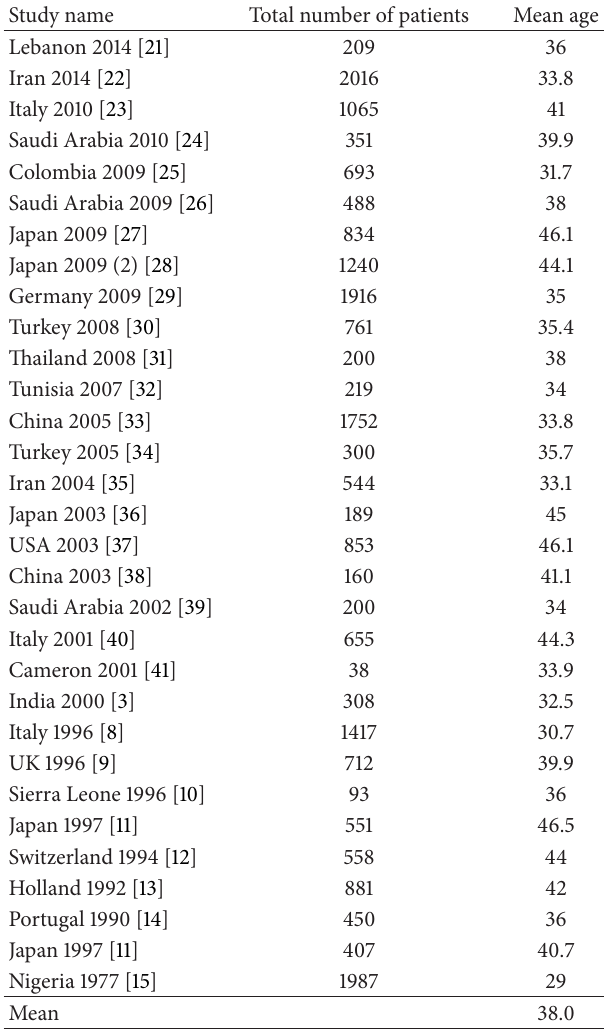
Table 1: Mean age at presentation in uveitis epidemiology